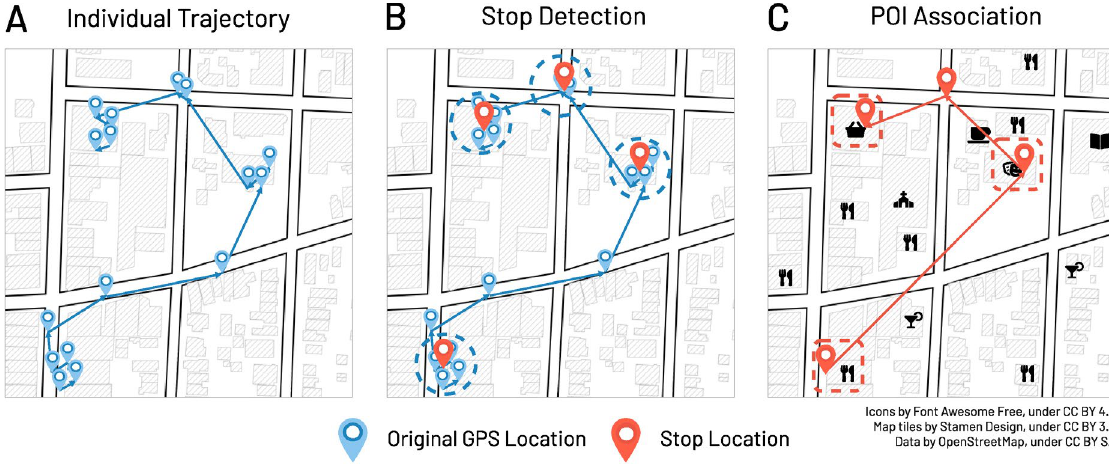
Figure 1. ( A ) From an individual’s original GPS trajectory, we detect a stop whenever the individual spends at least 5 minutes within a distance of 65 meters from a given trajectory point. ( B ) We detect stop locations through a combination of the Lachesis 37 and DBSCAN algorithms 38 . ( C ) If present, we associate each stop location to the nearest Point Of Interest (POI) within a distance of 65